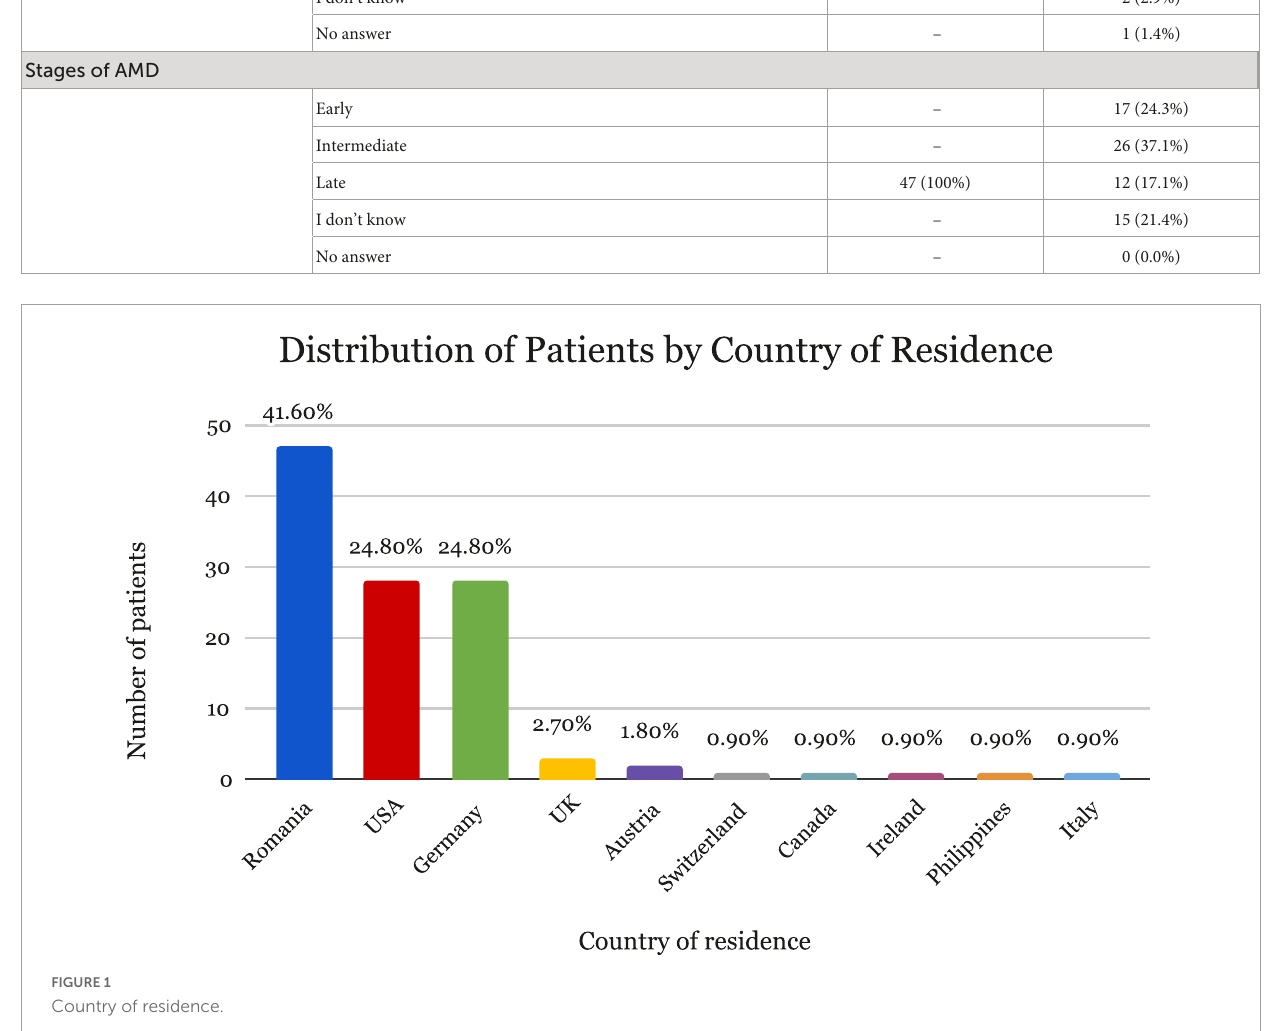
FIGURE1 Country of residence.